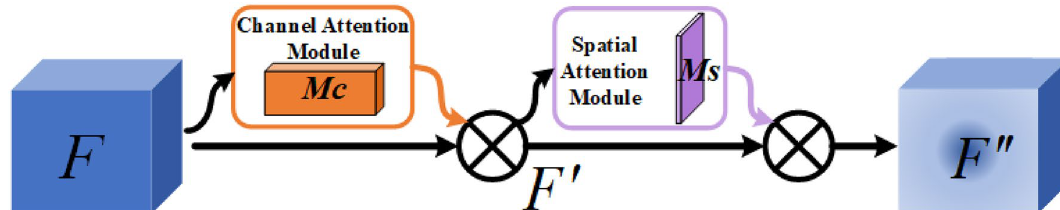
Figure 8. Convolutional block attention mechanism.